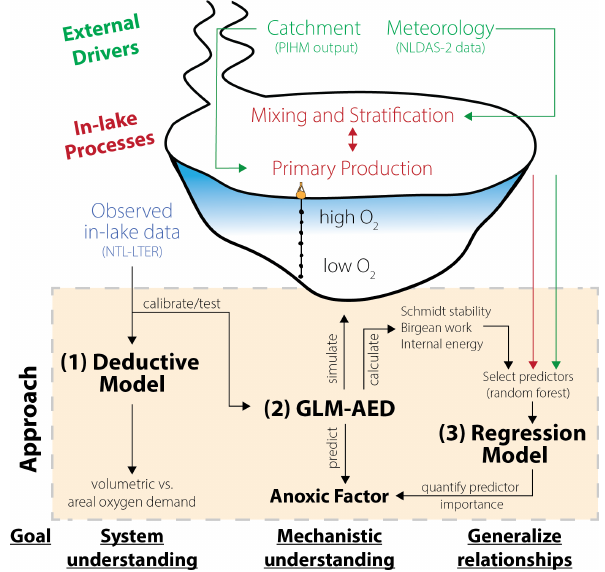
Figure 2. Schematic overview of the modeling workflow: (1) ap- plication of a deductive model to further our system understanding about oxygen sink terms; (2) replication of Lake Mendota using GLM-AED2 to investigate hydrodynamic and ecosystem mecha- nisms; and (3) application of regression models to quantify the im- portance of ecosystem predictors on the anoxic